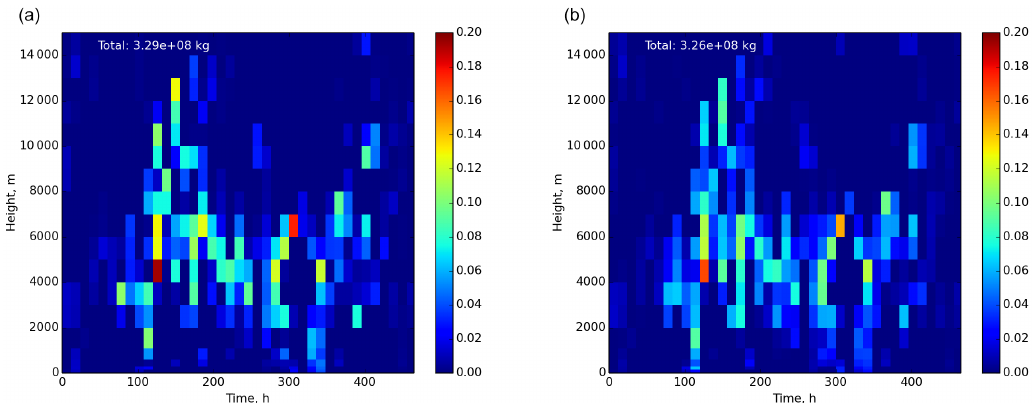
Figure 5. Inversion results with real observations: emission flux (kgm − 1 s − 1 ) obtained using 4D-Var (left) and by evaluating the sensitivity matrix (right). The inversions are based on total column observations.